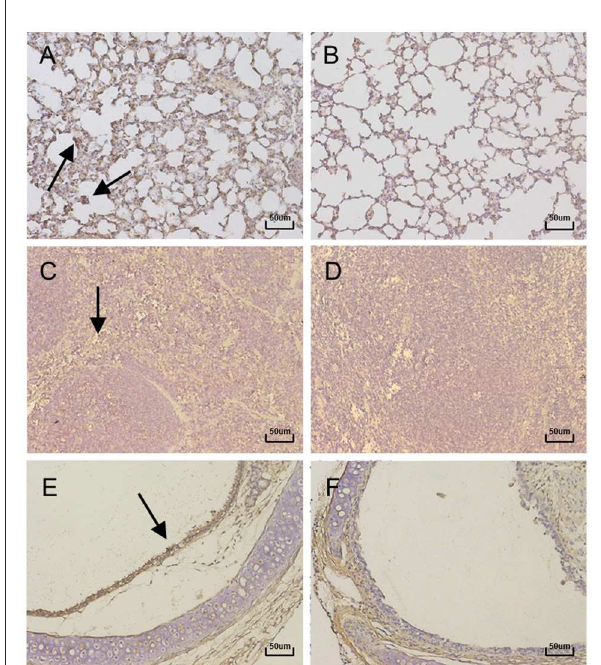
FIGURE5 Immunohistochemistry of lung, Spleen and Trachea sections of mice (400 × ). Representative histological sections from lung tissue of mice at 3 days PI. (A) lung tissue of control. (B) Spleen tissue at 5 days PI. (C) Spleen tissue of control. (D) Trachea tissue at 13 days PI. (E) Trachea tissue of control. (F) were stained with immunohistochemical (IHC) using antibody specific for BAdV-3. Positive signals were indicated with black